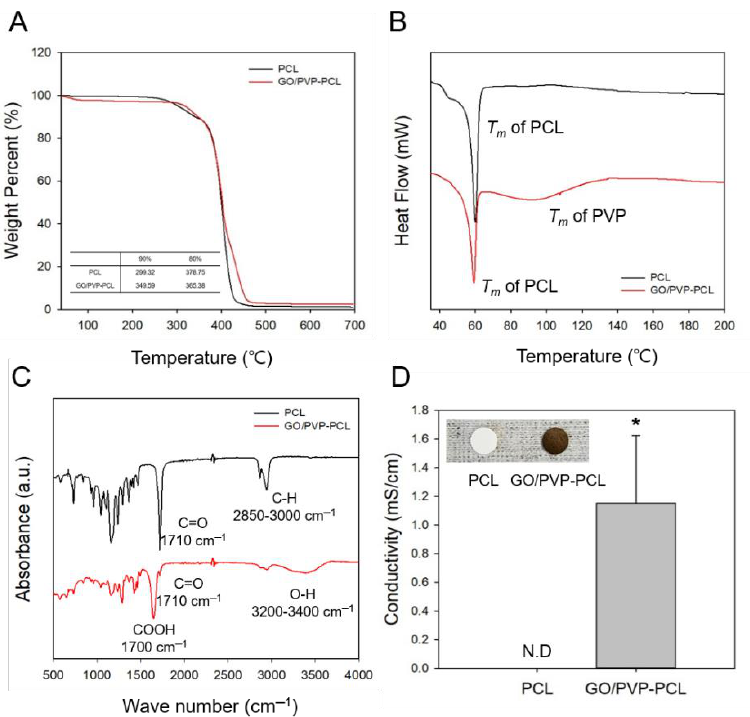
Figure 4. Characterization of PCL and GO/PVP-PCL: ( A ) Thermogravimetric analysis (TGA); ( B ) Differential scanning calorimetry (DSC); ( C ) FTIR spectra; ( D ) Conductivity.